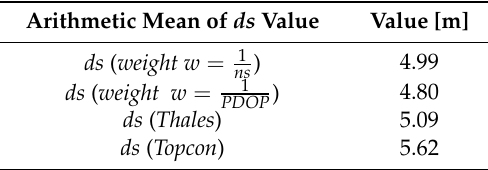
Table 5. The results of ds